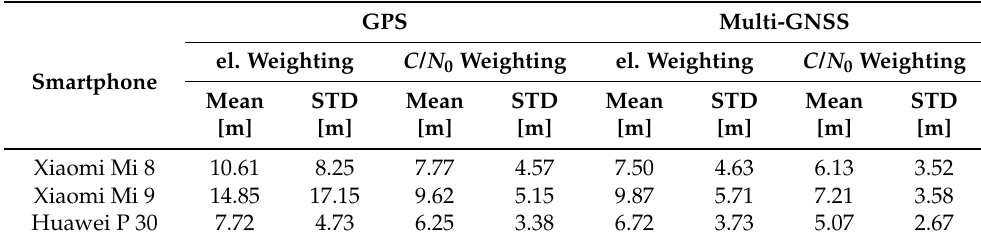
Figure 11. Three-dimensional coordinate error box-plots for GPS and multi-GNSS solutions with both C / N 0 and elevation-dependent weighting schemes. Xiaomi Mi 8, Xiaomi Mi 9, and Huawei P30 smartphones are shown in the first, second, and third panels, respectively. A cut-off threshold of 90 m is used to achieve a better visibility. Red crosses represent the outliers. Table 3. Three-dimensional coordinate error statistics (mean and STD) for GPS and multi-GNSS solutions with elevation and C / N 0 -dependent weighting